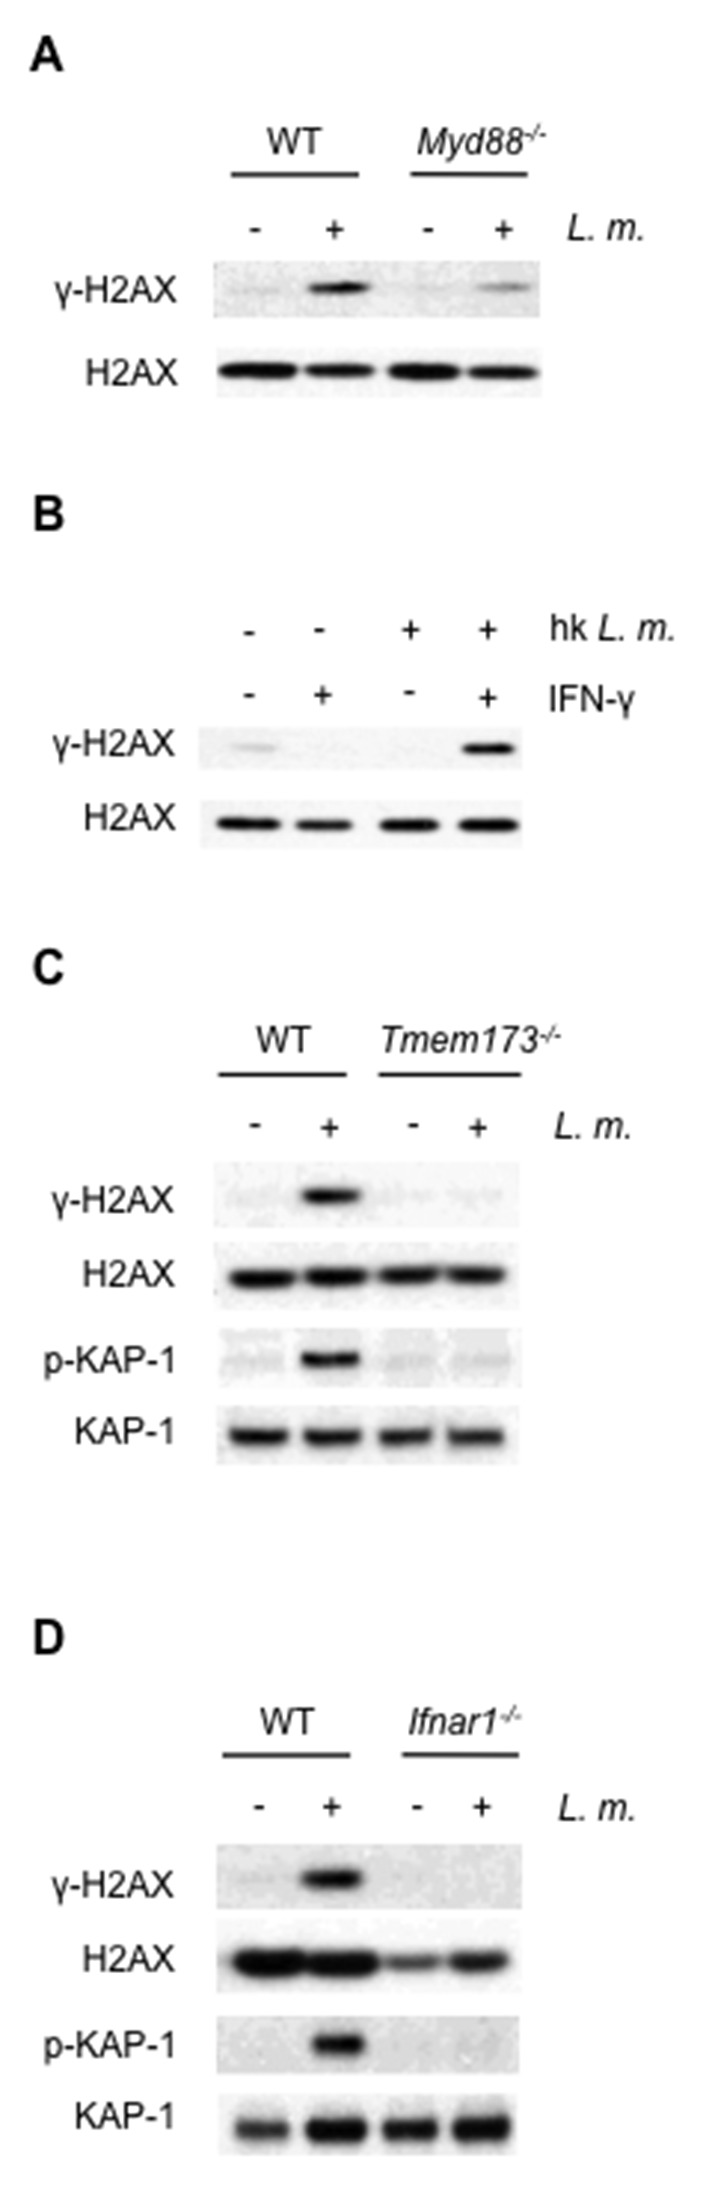
The DDR depends on TLR and interferon signaling cascades.(A,B) Western blotting for γ-H2AX and H2AX in whole cell lysates from (A) WT or Myd88-/- BMDMs after no infection (-) or infection (+) with L. monoctytogenes (L. m.) for 24 hr. (B) WT BMDMs after no treatment (-) or treatment (+) with IFN-γ, heat-killed L. monocytogenes, or both for 9 hr. (C, D) Western blotting for γ-H2AX, H2AX, p-KAP-1, and KAP-1 in whole cell lysates from WT, Tmem173-/- (C) or Ifnar1-/- (D) BMDMs after no infection (-) or infection with L. m. for 24 hr. Data are representative of 2–4 independent experiments.